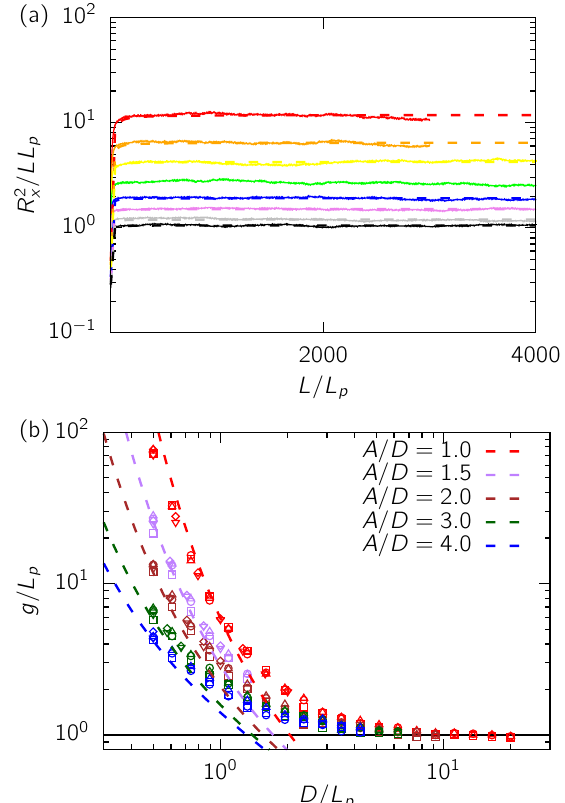
Figure 2. ( a ) Illustration of our method for obtaining the global persistence length. The curves here correspond to a subset of Set 1a (see Table 1) of our data for a fixed aspect ratio of A / D = 2 and L p / b = 10. The solid curves are our simulation data and the dashed lines are the best fits for Equation (17). The red curve corresponds to the smallest channel size D / L p = 0.5 and the black curve corresponds to the biggest channel size of D / L p = 1.94. The channel size increases from top to bottom; ( b ) the global persistence length thus obtained for all our data in Table 1 against dimensionless channel size. The five colors represent the five aspect ratios considered here. The different point types correspond to L p / b = 10 ( (cid:3) ), L p / b = 12.5 ( (cid:53) ), L p / b = 15 ( (cid:13) ), L p / b = 17.5 ( (cid:5) ) and L p / b = 20 ( (cid:52) ). The dashed lines are from Equation (21). The horizontal black line indicates g = L p , which should be the limiting value of g for D (cid:29) L p